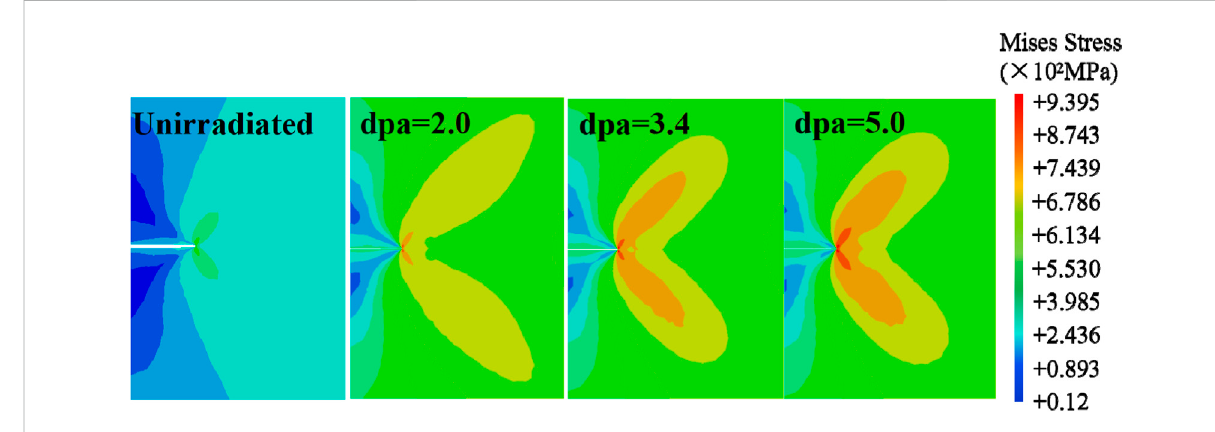
FIGURE 7 Contour plot of Mises stress fi elds at the crack tip under different displacement per atom (dpa) values.